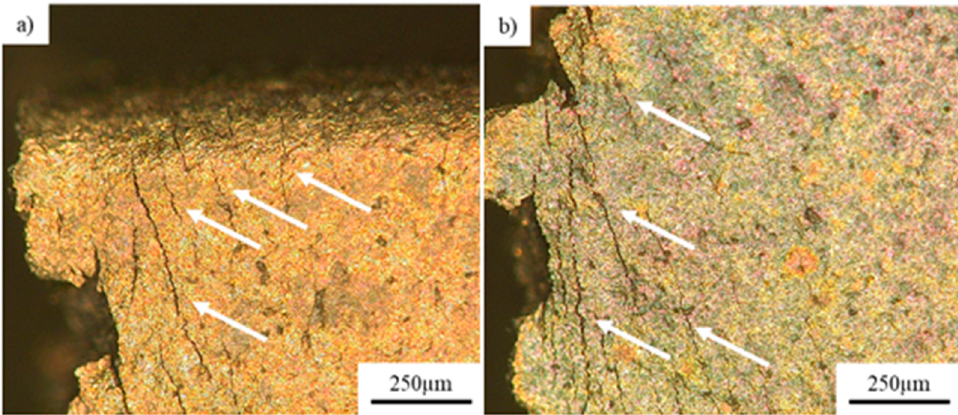
Figure 5. Microscopic views of the side surfaces of specimens after fatigue tests with visible crack- ing of the layer in the direction perpendicular to that of deformation: ( a ) edge of the specimen; ( b ) center of the